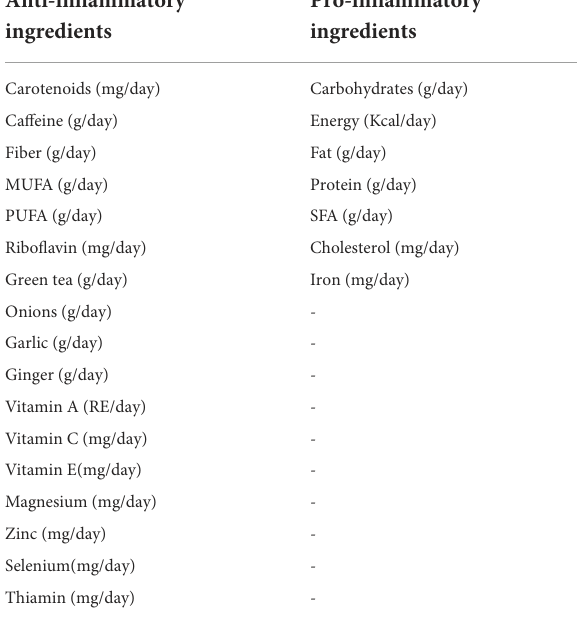
TABLE 1 Pro-inflammatory and anti-inflammatory ingredients. Anti-inflammatory ingredients